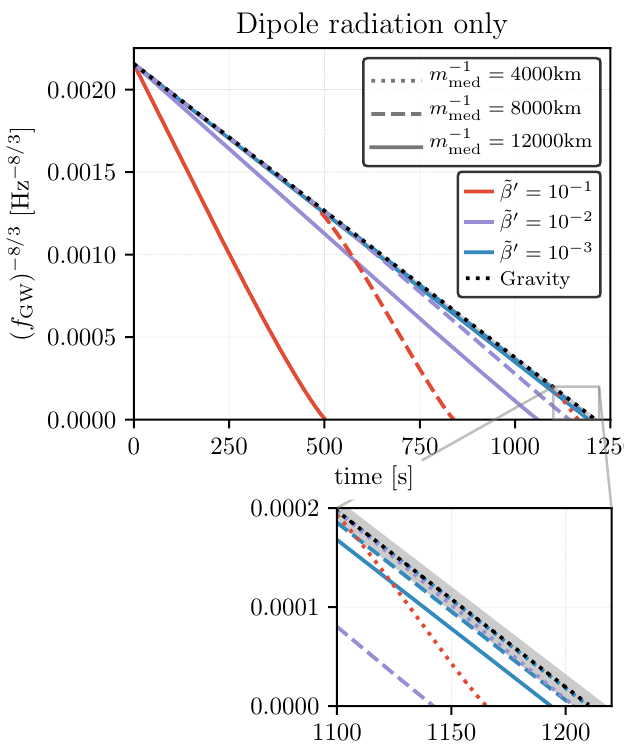
Figure 2 . Gravitational wave frequency f (cid:0) 8 = 3 ( t ) as a function of time for a neutron star binary with GW various values of the (cid:12)fth-force parameters e (cid:12) 0 and m med . We consider here the limit that the system loses energy via dipole radiation and gravitational wave emission, but that the latter is una(cid:11)ected by a dark force acting between the binary partners. This situation is realized if one of the stars does not contain any dark sector particles. We show results for m (cid:0) 1 = f 4000 ; 8000 ; 12 000 g km (dotted, med dashed, solid lines) and three choices of e (cid:12) 0 = f 10 (cid:0) 1 ; 10 (cid:0) 2 ; 10 (cid:0) 3 g (red, purple, and blue colored lines). The gray band indicates the typical error on reconstructing the chirp mass, which we take to be 0.4% based on ref. [4]. The boundary condition of the di(cid:11)erential equation is the